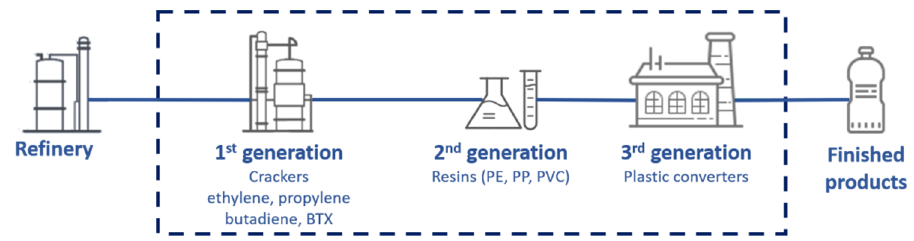
Figure 2. Schematic representation of a typical fossil-based plastic chain.